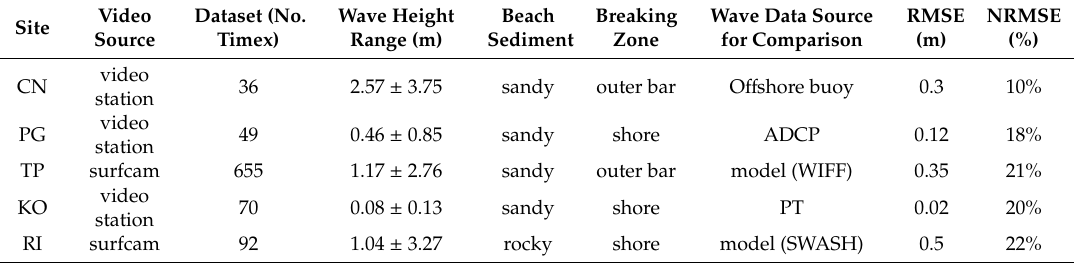
Table 3. Details of 𝐻𝑠 (cid:3029),(cid:3049)(cid:2870)(cid:2872) results, coupled to video device, morphological characteristics, and wave data source for each considered site, namely CN (Costa Nova), PG (Praia Grande), TP (Tarquinio- Paraiso), KO (Kourou), and RI (Ribeira d’Ilhas, development site).